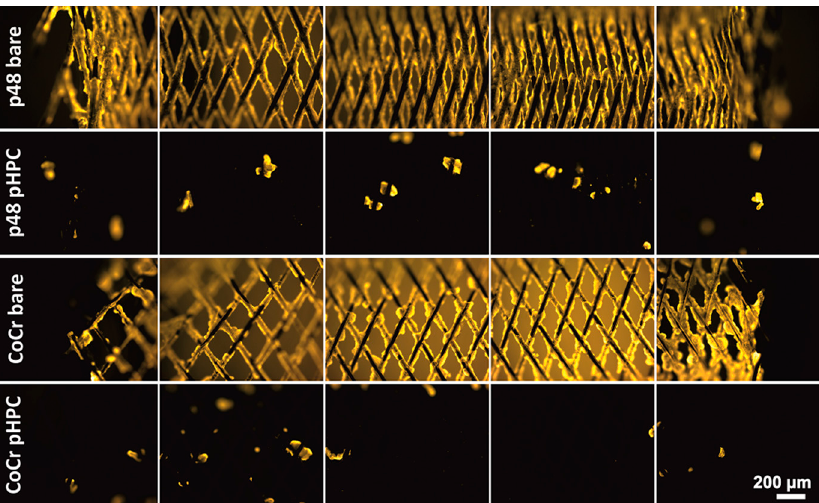
Figure 4. Representative fluorescence micrographs of uncoated and pHPC-coated p48 MW and CoCr specimens. The devices were incubated in whole human blood in a modified Chandler loop flow model under dynamic conditions at 37 °C for 120 min. Adherent platelets were stained with a CD61 antibody (yellow fluorescence). Though the uncoated devices were completely covered with adherent platelets, there were considerably fewer fluorescent cells on the pHPC-coated braids. (Scale bar for all images 200 µm.)